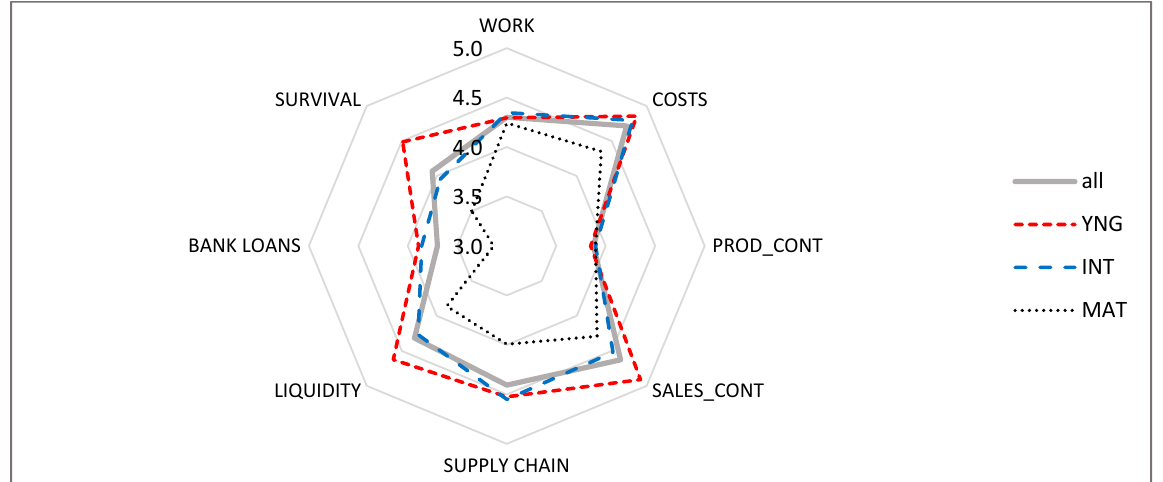
Figure 3. Perception of the COVID-19 interruptions and business age (AGE_2).